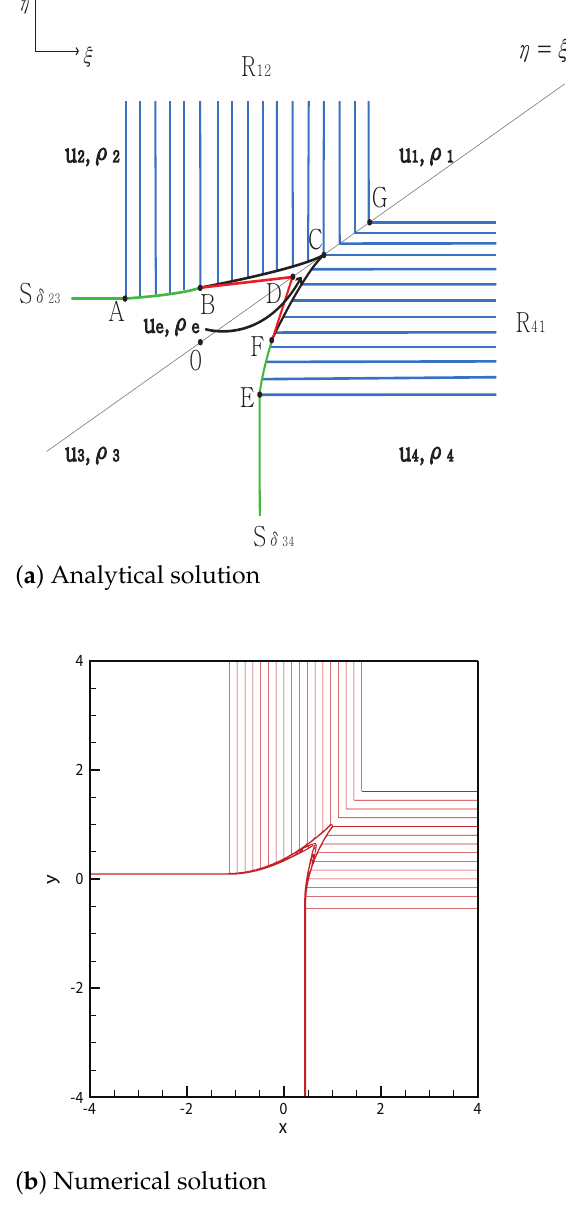
Figure 3. Case 3. R + S δ + S δ + R . Case 4. S δ + R + R + S δ ( u 1 < u 3 < 0 < u 4 < u 2